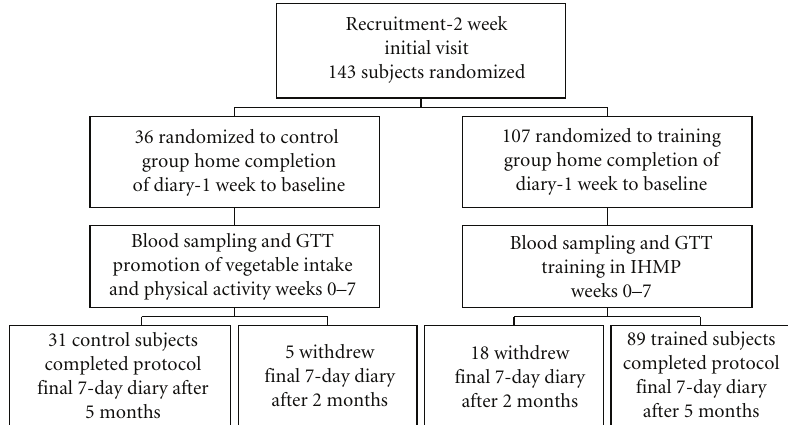
Figure 1: Consort flow chart and investigation design . Randomized controlled 5-month clinical investigation to study the metabolic e ff ects of the